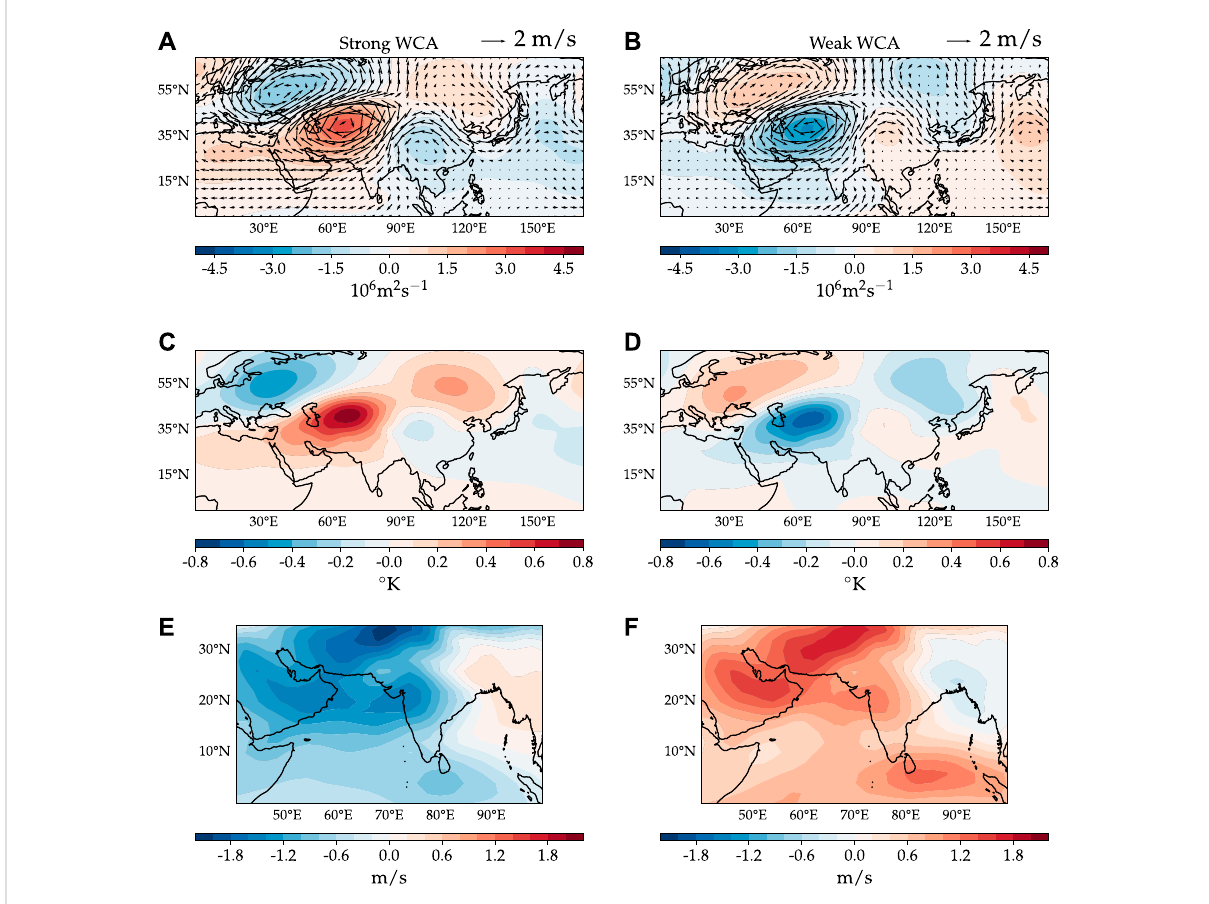
FIGURE 1 Composites of 200 hPa eddy stream function (shaded) and wind vectors (A,B) , tropospheric temperature (C,D) and easterly shear (E,F) for strong (left panel) and weak (right panel) WCA